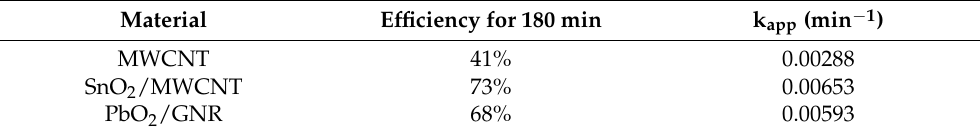
Table 1. Degradation efficiency and apparent rate constants for the investigated electrodes. Material Efficiency for 180